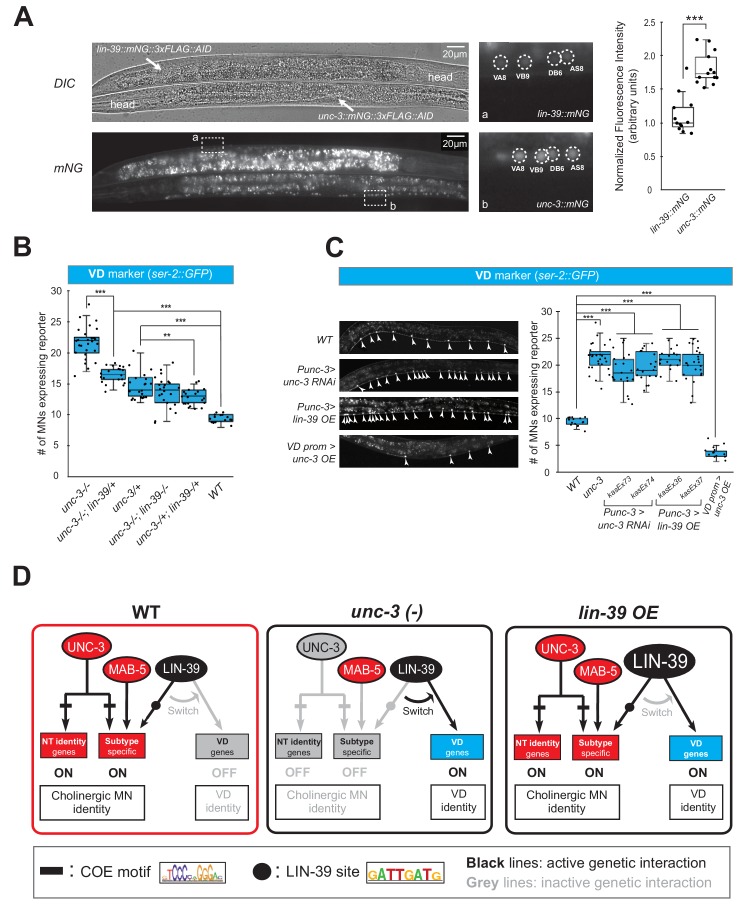
Gene dosage experiments suggest that LIN-39 is the rate-limiting factor.(A) The endogenous expression levels of UNC-3 are higher than LIN-39. The DIC and mNG channels of two worms next to each other on the same slide with the genotype of lin-39::mNG::3xFLAG::AID (top, anterior right, ventral up) and unc-3::mNG::3xFLAG::AID (bottom, anterior left, ventral down) respectively are shown on the left. VNC regions indicated by dashed frame (a, b) are zoomed in at the middle panel with dashed circles around MN nuclei. The identities of these MNs are shown (e.g., VA8, VB9). The same cholinergic MNs have stronger expression levels of endogenous unc-3::mNG than lin-39::mNG. Quantification of the fluorescence intensities is shown on the right panel. For details on the quantification, see Materials and Materials and methods. N = 12. ***p<0.001. (B) Quantification of the VD marker (ser-2::gfp) in unc-3 (n3435), unc-3 (n3435); lin-39 (n1760)/+, unc-3 (n3435)/+, unc-3 (n3435); lin-39 (n1760), unc-3 (n3435)/+; lin-39 (n1760)/+, and WT animals at L4. N > 15. **p<0.01, ***p<0.001. (C) Representative images of the VD marker (ser-2::gfp) expression on the left in L4 stage transgenic animals that either down-regulate unc-3 in cholinergic MNs (Punc-3 >unc-3 RNAi), over-express lin-39 in cholinergic MNs (Punc-3 >lin-39 OE), or over-express unc-3 in VD neurons (VD prom [unc-47 prom]>unc-3 OE). Arrowheads point to MN cell bodies with gfp marker expression. Green fluorescence signal is shown in white for better contrast. Quantification is provided on the right. Two independent transgenic lines were used for Punc-3 >unc-3 RNAi and Punc-3 >lin-39 OE. N > 13. ***p<0.001. (D) Schematic summarizing the gene dosage experiments.